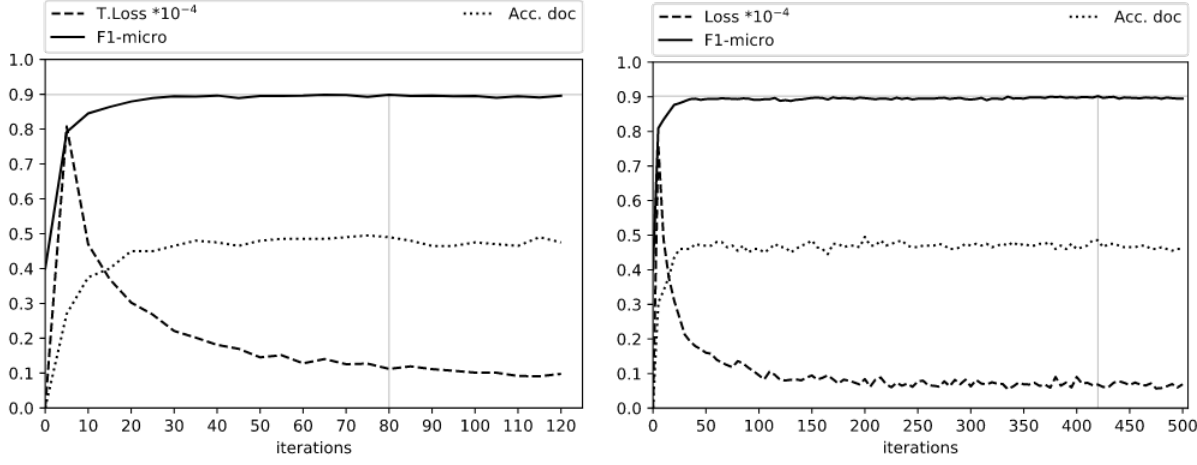
Figure 4. ‘PER’ experiment with 0.35 dropout rate for 120 and 500 epochs. Best F1-micro scores are 0.8986 in round 80 and 0.9021 in round 420, respectively.